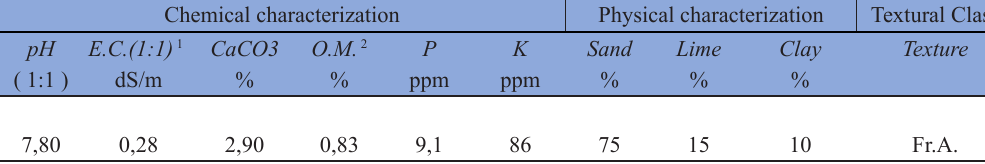
1 CE= Electric conductivity 2 O.M. = soil organic matter content,